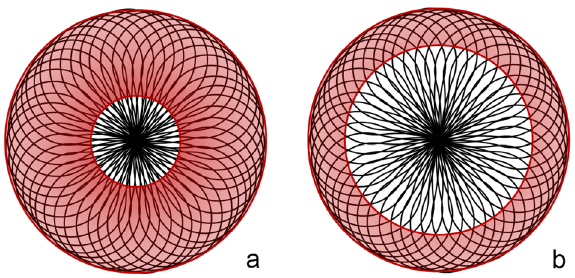
Figure 1. Schematic comparison of the Contour device in narrow- and wide-necked aneurysms. In both figures, the red circles depict aneurysms, with the inner circles representing the aneurysm neck and the outer circle the aneurysm dome. Image a represents ( a ) narrow-neck aneurysm and ( b ) a wide-neck aneurysm. Due to its geometry, there is a very high mesh density of the Contour device at the entry level of narrow-neck aneurysms, likely causing a favourably higher flow-disrupting effect ( a ) compared to wide-neck aneurysms ( b